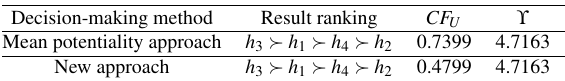
Table 18: The comparison results of the substantial uncertainty factors of overall uncertainty Decision-making method Result ranking CF U ϒ Mean potentiality approach h 3 (cid:14) h 1 (cid:14) h 4 (cid:14) h